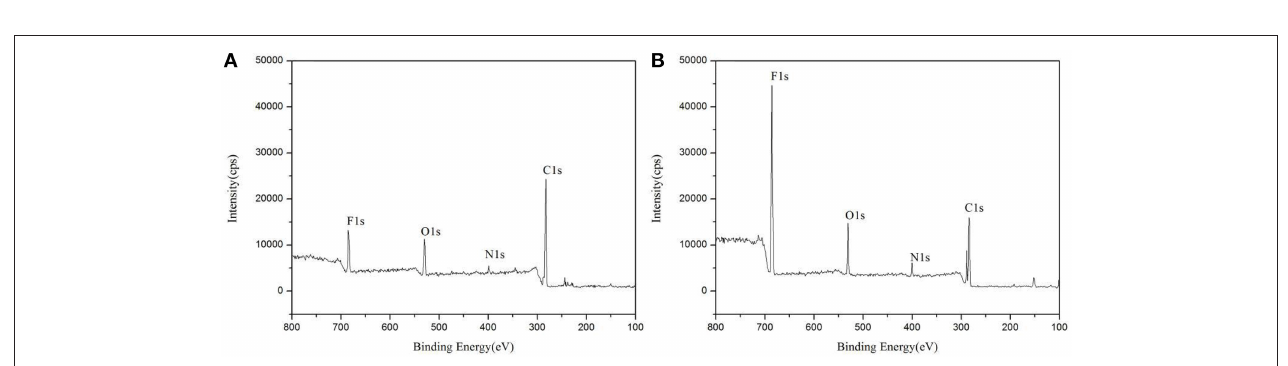
FIGURE 3 | SEM images of PVDF/IL (a,b) and PVDF/IL/CNTs (1:4:1:0.08) (c,d) with different magnifications of 5000 × (a,c) and 30,000 × (b,d) .